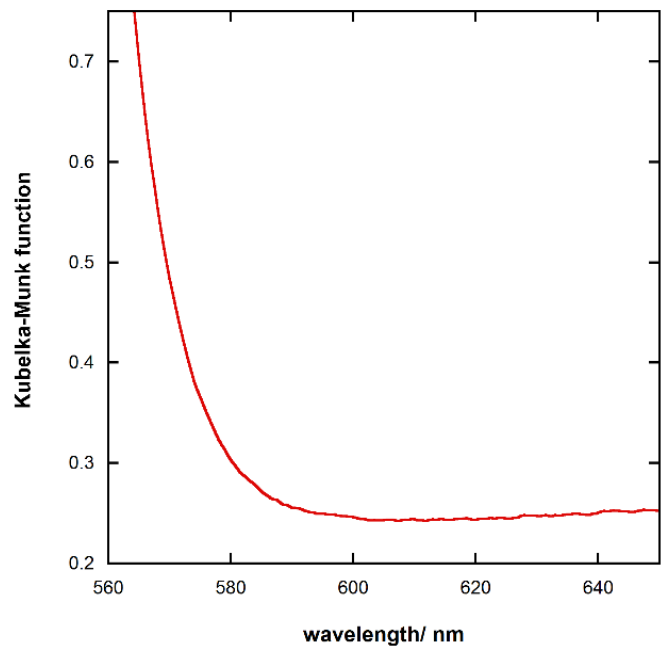
Figure 3. UV-Vis spectrum of Pb 3 O 4 . Table 1. Band gap values of the Pb 3 O 4 obtained from the absorption onset of the UV-Vis spectra (first line) and those calculated by Tauc’s plots considering the possible transition types. The calculated value that agree better with the absorption onsets is reported in bold.